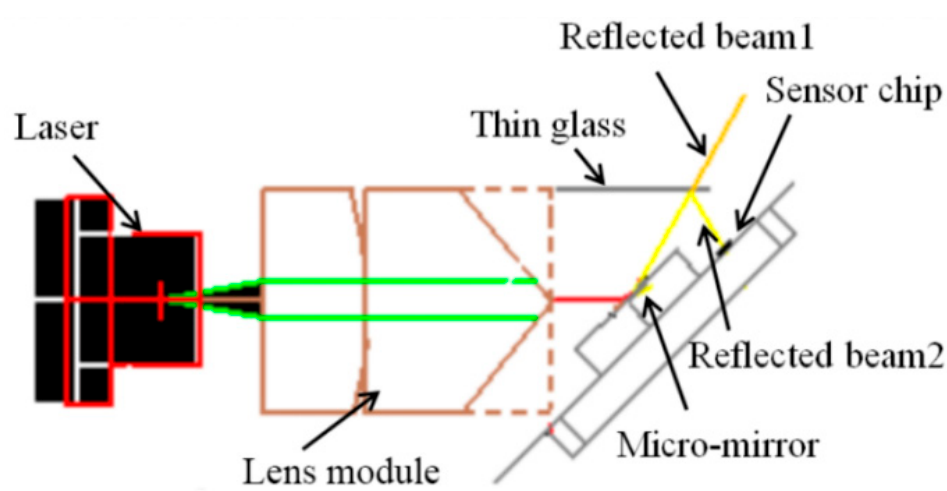
Figure 1. The architecture of the structure light system.